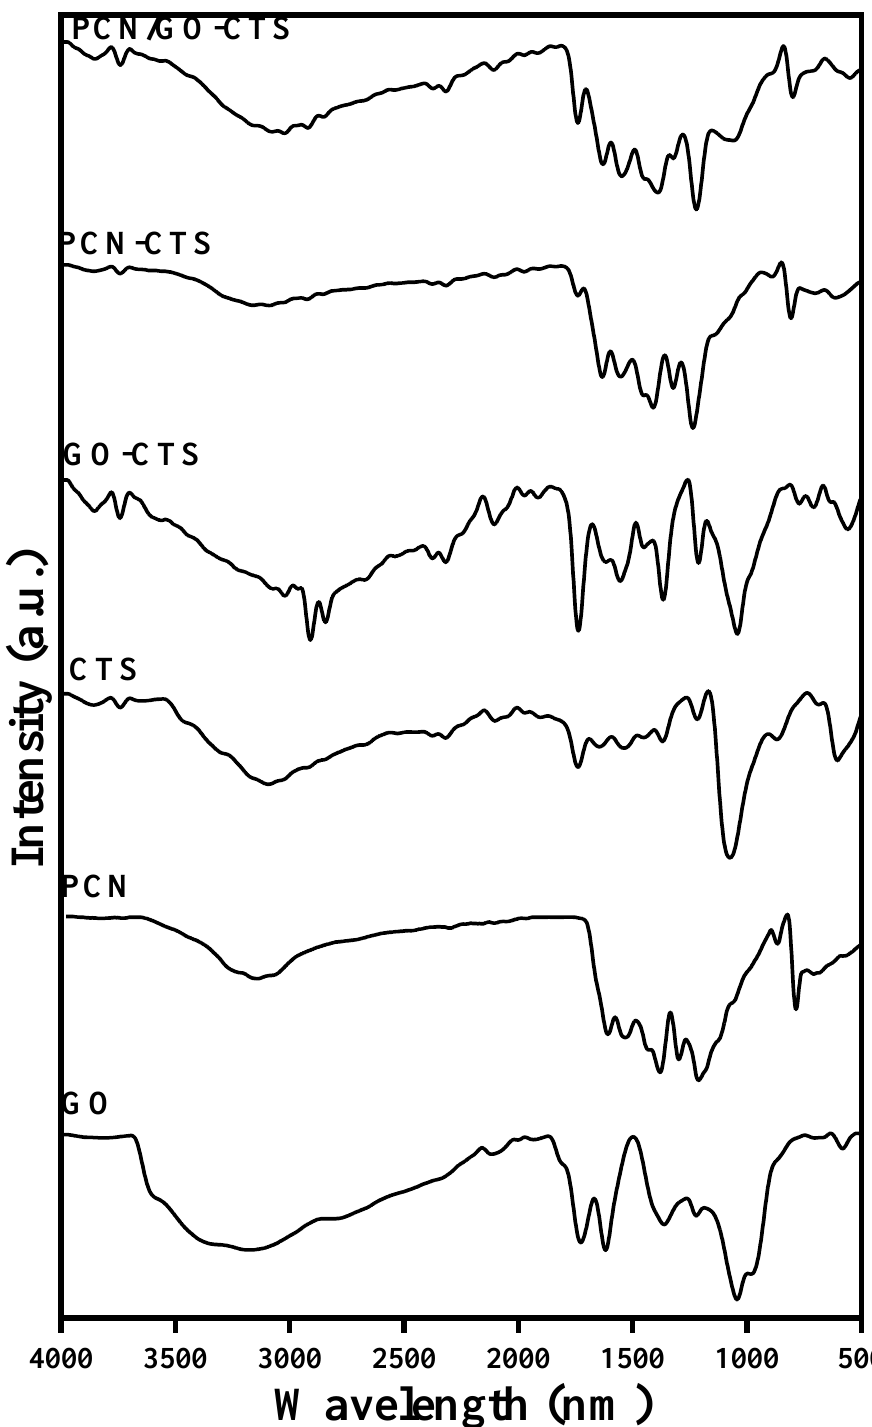
Figure 1. FTIR spectra of GO, PCN, CTS, GO-CTS, PCN-CTS, and PCN/GO-CTS. There was a significant reduction in crystallinity in the XRD pattern of the composites, with PCN having the most influence on the crystallinity of CTS. Although the prominent peaks of CTS could still be observed in GO-CTS, albeit with a significant broadening of the peak around 28 ◦ , the CTS peaks were completely masked by the PCN peaks in PCN-CTS. This was also observed in the PCN/GO-CTS composite, which further confirms the strong interaction between PCN and CTS